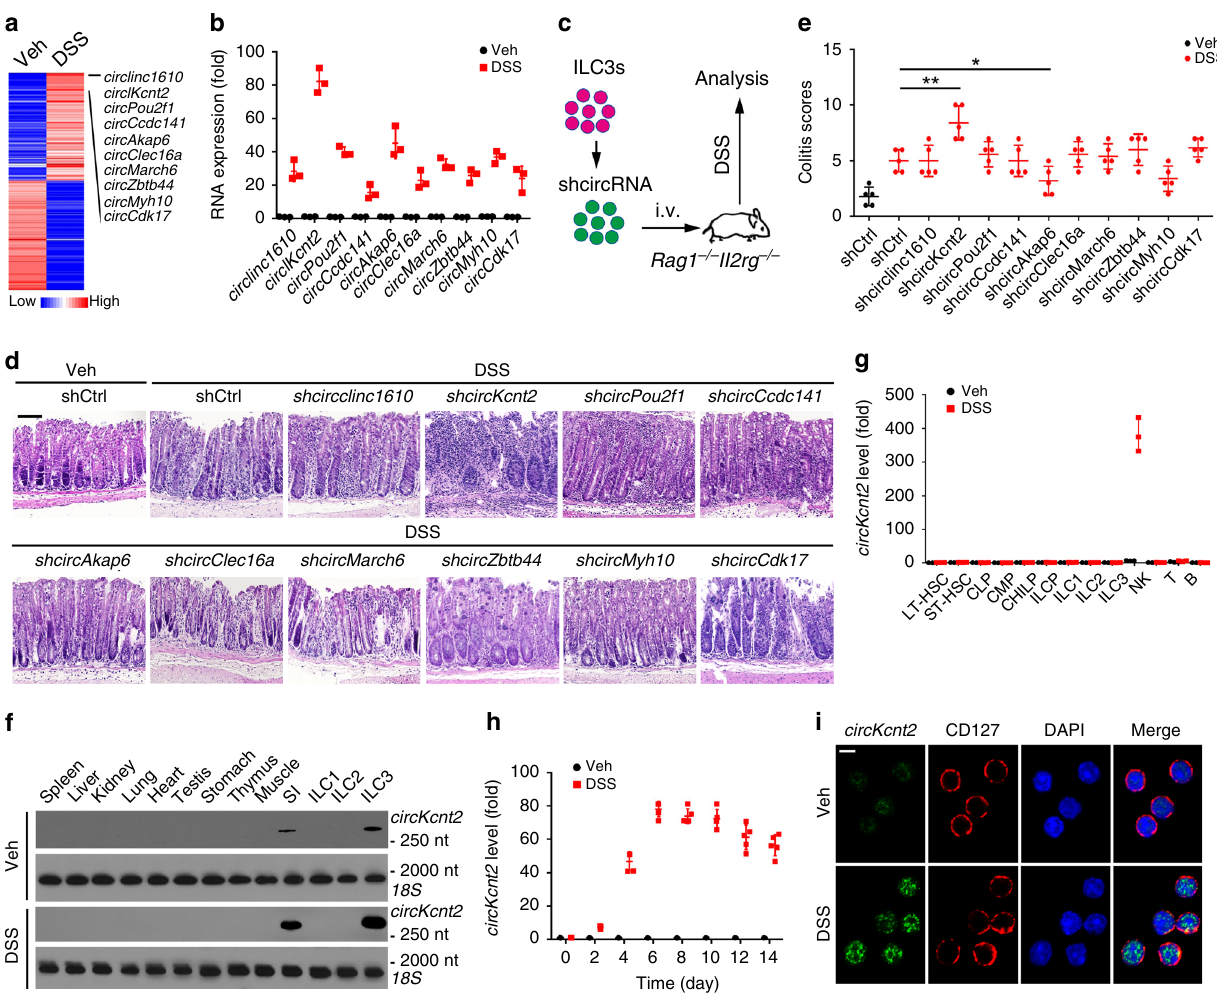
Fig. 1 CircKcnt2 is highly induced in ILC3s during intestinal in fl ammation. a Heatmap of differentially expressed circRNAs (100 most upregulated and 100 most downregulated) in small intestinal ILC3s (Lin − CD45 low CD90 high ) from Rag1 − / − mice treated with or without DSS. ILC3s in intestines were isolated by FACS, followed by circRNA microarray analysis. Veh vehicle. b qRT-PCR analysis for top ten upregulated circRNAs in small intestinal ILC3s from DSS- treated Rag1 − / − mice. n = 3 independent samples. c ILC3s isolated from DSS-treated Rag1 − / − mice were infected with lentiviruses carrying shRNAs against circRNAs for 48 h. Then 3 × 10 4 GFP + ILC3s per mouse were transplanted into Rag1 − / − Il2rg − / − mice. Two weeks later, Rag1 − / − Il2rg − / − mice were treated with DSS, followed by analysis. d H&E staining of colons from transplanted Rag1 − / − Il2rg − / − mice as treated in c . Scale bar, 100 μ m. e Colitis scores of indicated mice after DSS treatment as in c (* P = 0.0399; ** P = 0.0031). n = 5 for each group. f Northern blotting analysis for circKcnt2 expression in different tissues from Rag1 − / − mice treated with or without DSS. g qRT-PCR analysis for circKcnt2 expression in indicated hematopoietic cells isolated from WT mice treated with or without DSS. n = 3 independent samples. h CircKcnt2 expression in ILC3s from Rag1 − / − mice treated with 3% DSS was analyzed at different time points. n = 5 independent samples. i ILC3s were isolated from Rag1 − / − mice treated with 3% DSS and then circKcnt2 expression was detected by fl uorescence in situ hybridization (FISH). Biotin-labeled head-to-tail RNA probes were in green. Nuclei were counterstained with DAPI. Scale bar, 5 μ m. * P < 0.05 and *** P < 0.001. Data were analyzed by an unpaired Student ’ s t -test and shown as means ± SD. Data are representative of at least three independent experiments. Source data are provided as a Source Data fi We then generated circKcnt2 − / − Rag1 − / − mice through crossing amounts of IL-17 than circKcnt2 + / + Rag1 − / − ILC3s (Fig. 2d). We circKcnt2 − / − mice with Rag1 + / − mice, followed by DSS treatment. next overexpressed circKcnt2 in circKcnt2 − / − ILC3s for rescue We found that ILC3s of circKcnt2 − / − Rag1 − / − mice expressed assay. As expected, circKcnt2 was really restored in circKcnt2 − / − ILC3s (Supplementary Fig. 3j). Restoration of circKcnt2 in much more amount of Il17a after DSS treatment compared to circKcnt2 − / − Rag1 − / − ILC3s could inhibit IL-17 generation (Sup- circKcnt2 + / + Rag1 − / − mice (Fig. 2a). Furthermore, IL-17 + ILC3 numbers in DSS-treated circKcnt2 − / − Rag1 − / − mice were much plementary Fig. 3k). These data indicate that circKcnt2 suppresses greater than those of circKcnt2 + / + Rag1 − / − mice (Fig. 2b). Of note, IL-17 + ILC3s of circKcnt2 − / − Rag1 − / − mice did not undergo cell death (Supplementary Fig. 3i). In addition, MFI of IL-17 + ILC3s from DSS-treated circKcnt2 − / − Rag1 − / − mice was much higher ulating ILC3 activation. We noticed that circKcnt2 − / − Rag1 − / − mice than that of circKcnt2 + / + Rag1 − / − mice (Fig. 2c), suggesting that circKcnt2 − / − Rag1 − / − ILC3s endowed IL-17-producing potential. In lost more body weight than circKcnt2 + / + Rag1 − / − mice after DSS fact, circKcnt2 − / − Rag1 − / − ILC3s produced more substantial treatment (Fig. 2e). And circKcnt2 − / − Rag1 − / − mice displayed